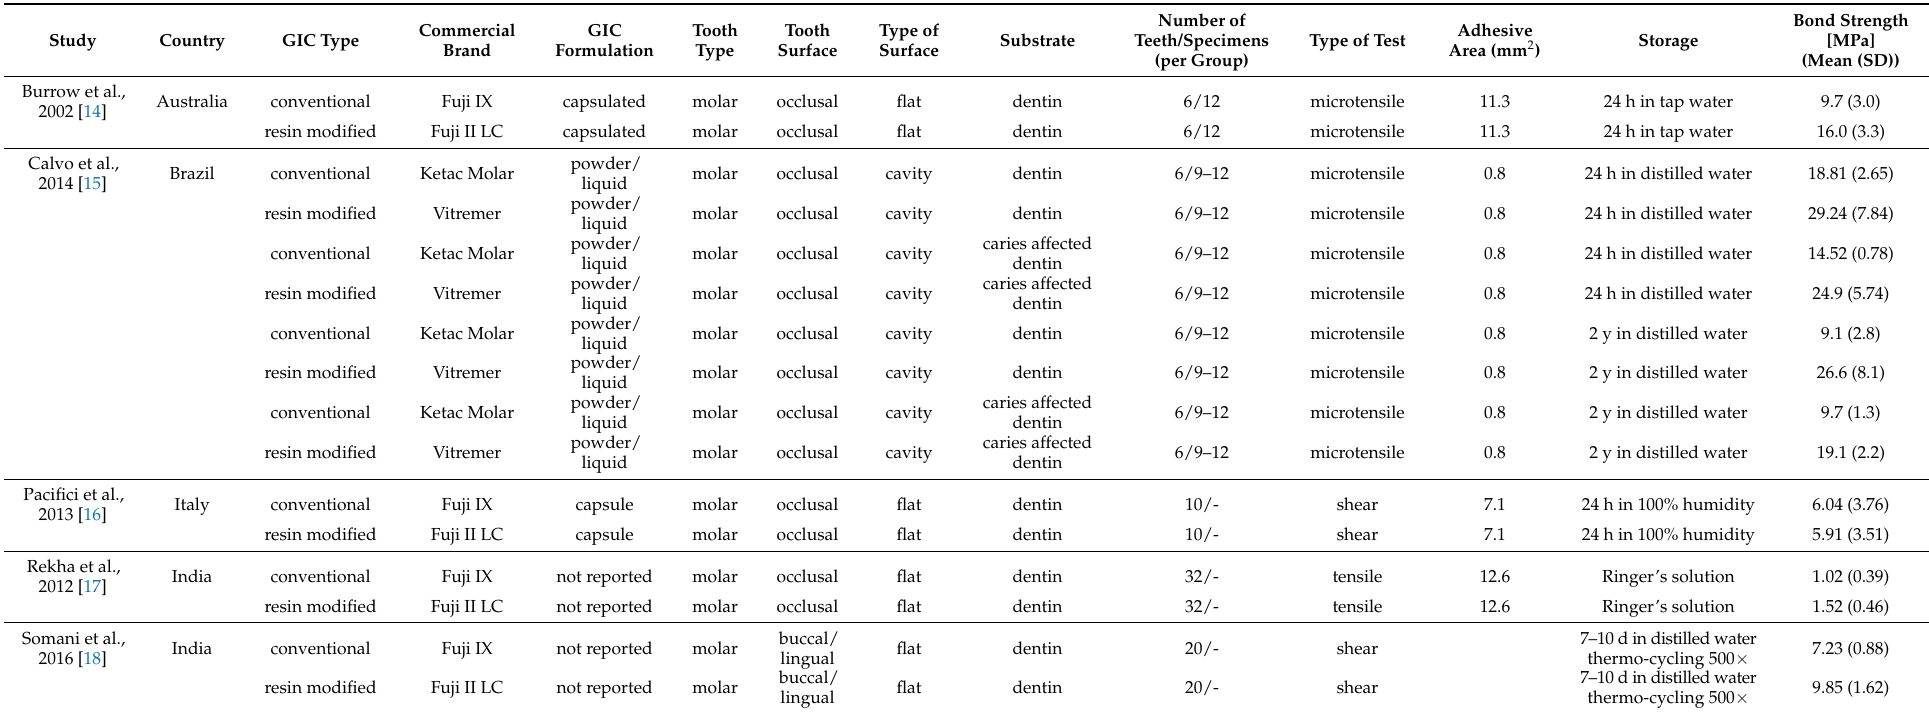
Table 1. Descriptive data of the included